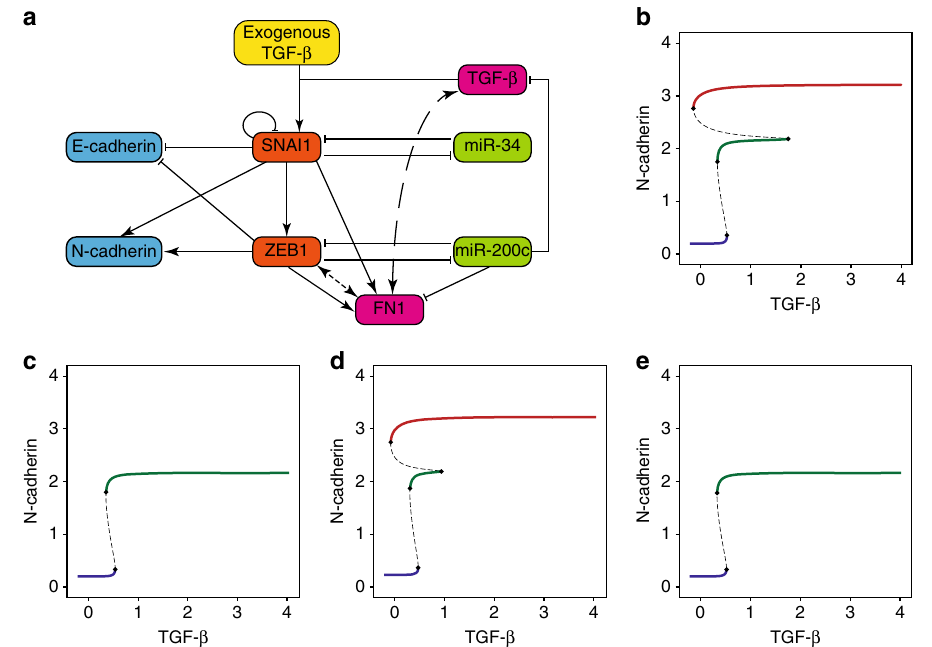
Fig. 5 Model incorporating FN1 recaptures EMT dynamics. a Graph illustrating the EMT-regulatory circuit incorporating FN1. Dotted lines represent ceRNA interactions. b Bifurcation analysis using the original EMT model of Zhang et al. 26 . c Bifurcation analysis using the original EMT model of Zhang et al. with an increased miR-200c half-life. Speci fi cally, the parameters controlling the recycling rates of miR-200c in the miR-200c-ZEB1 complexes increased from 0.5 to 0.9. d Bifurcation analysis using the EMT model incorporating FN1. e Bifurcation analysis simulating FN1 knockdown. Speci fi cally, the FN1 degradation rate constant in the EMT model incorporating FN1 increased to